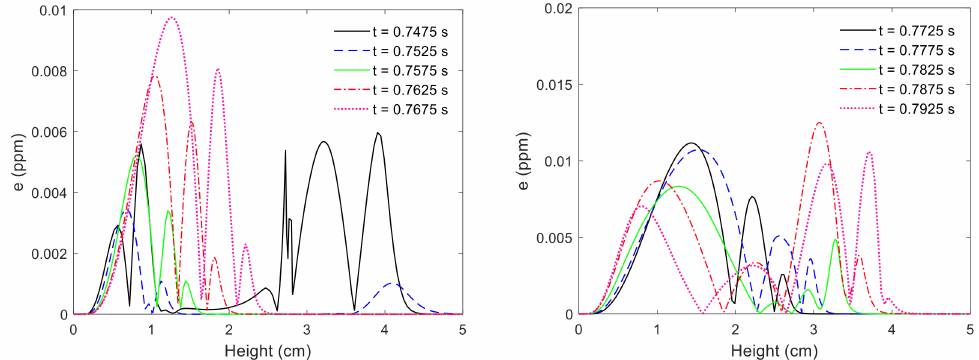
Figure 9. Absolute error for all time steps. Left: time steps 1–5, right: time steps 6–10.